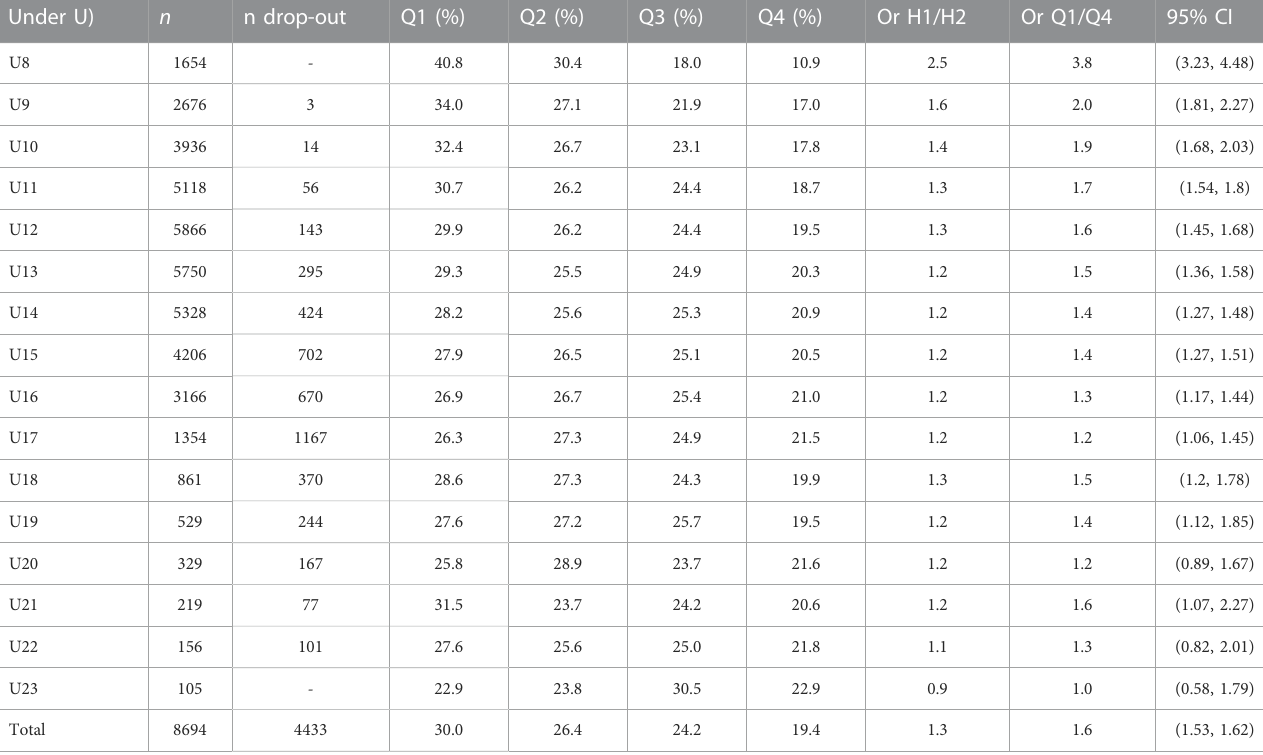
TABLE 1 RAEs of female long jumpers. Q1, Q4 = yearly quarters 1 and 4; OR = Odds ratio; CI = Con fi dence Interval. The number of athletes who did not participate for two consecutive seasons or more and who did not return to competition for more than 1 year were de fi ned as dropout. H1 = fi rst half year (Q1 + Q2). Under